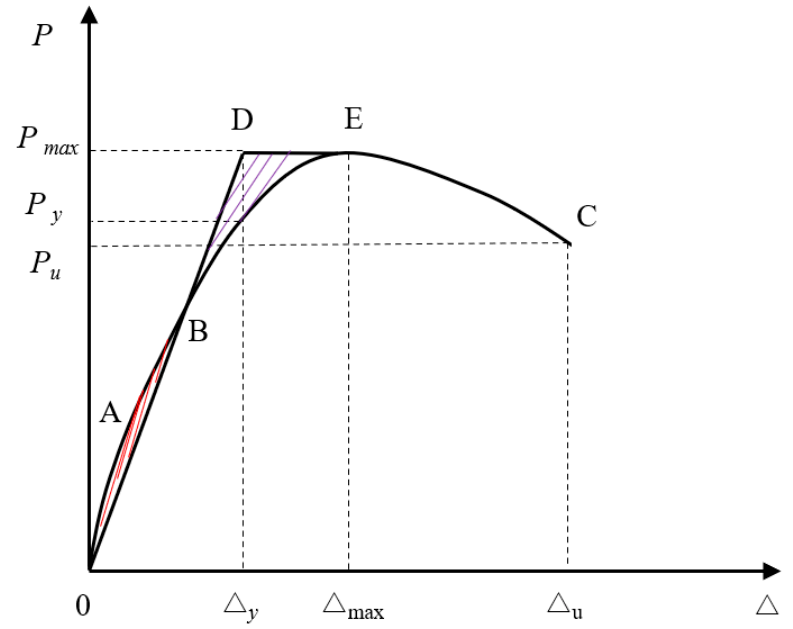
Figure 10. Energy equivalence method .